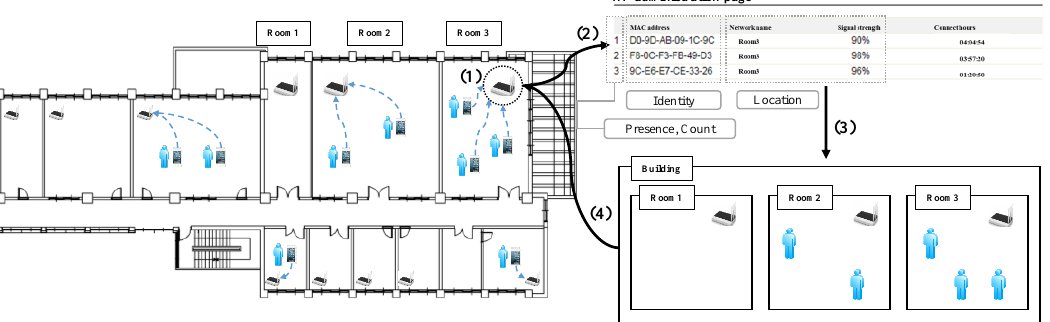
Figure 4. Real-time occupant information collection.